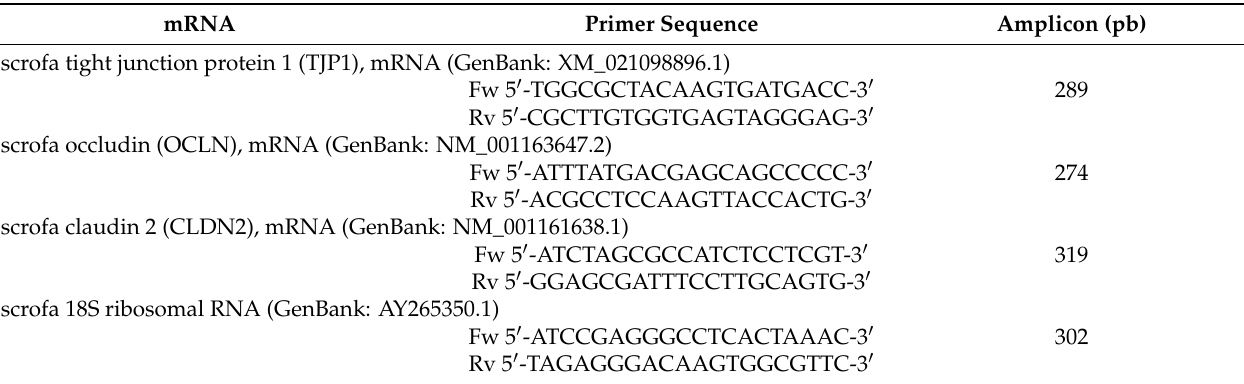
Table 2. Primers used for the quantitative PCR analyses of messenger RNA derived from TJP-1, Claudin-2, Occludin-1, and 18S ribosomal RNA 18S from pigs. mRNA Primer Sequence Amplicon